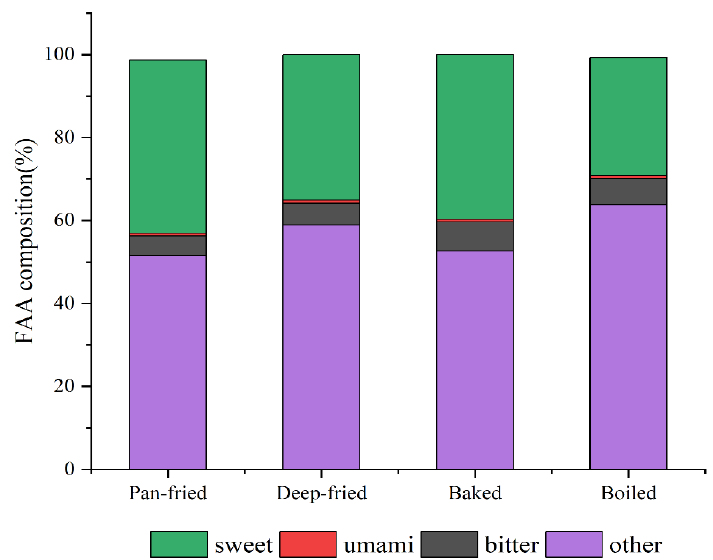
Figure 2. Amino acids composition of BTS meat after different thermal processing methods; sweet = (glycine + alanine + serine + threonine + proline + lysine); umami = (glutamic + acidaspartic acid); bitter = (tyrosine + arginine + histidine + valine + methionine + isoleucine + leucine + tryptophan + phenylalanine).